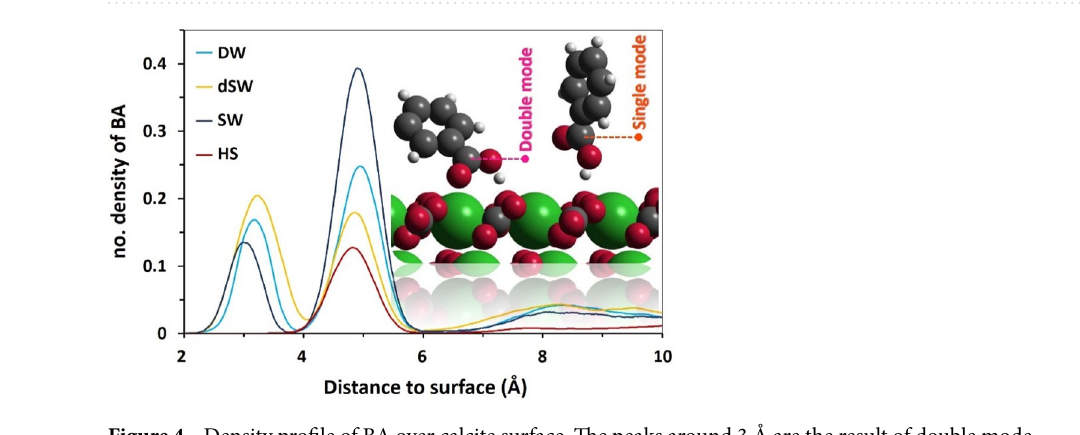
Figure 4. Density profile of BA over calcite surface. The peaks around 3 Å are the result of double mode interaction, while the ones nearby 5 Å are due to single mode. The inset is captured from simulation snapshots to represent two mode of interactions.